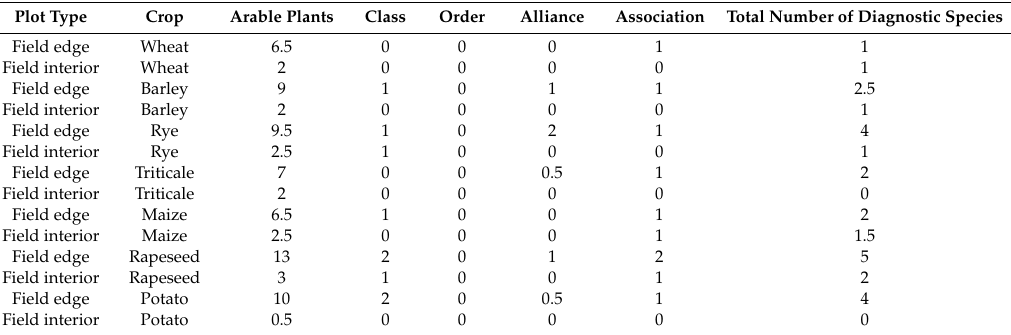
Table1. Numberofarableplantspeciessensustricto(definedbyHofmeisterandGarve[23])andnumber of species diagnostic for classes, orders, alliances or associations of arable plant communities (defined by Hüppe and Hofmeister [24]). Given are median values; n = 30 for edge plots of barley, maize, rapeseed, rye and wheat, potato = 28, triticale = 22; n = 10 for interior plots per crop.